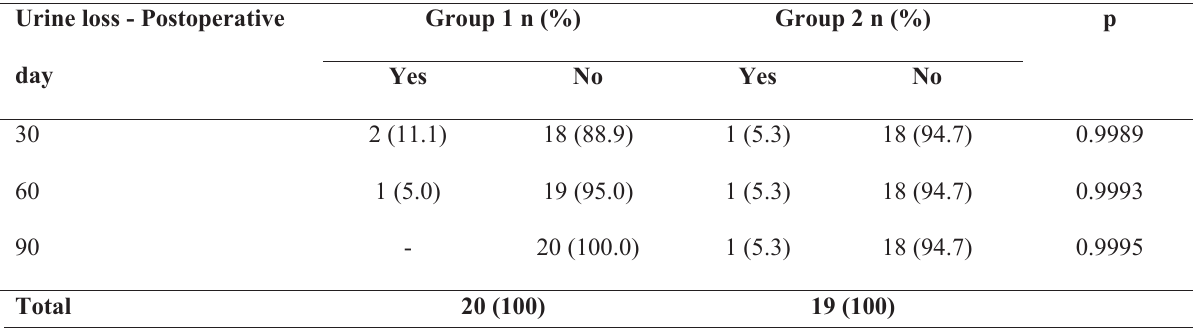
Table 2 – Postoperative spontaneous void after sling surgery for the treatment of stress urinary incontinence. Table 3 - Postoperative urinary incontinence after sling surgery for the treatment of stress urinary incontinence.